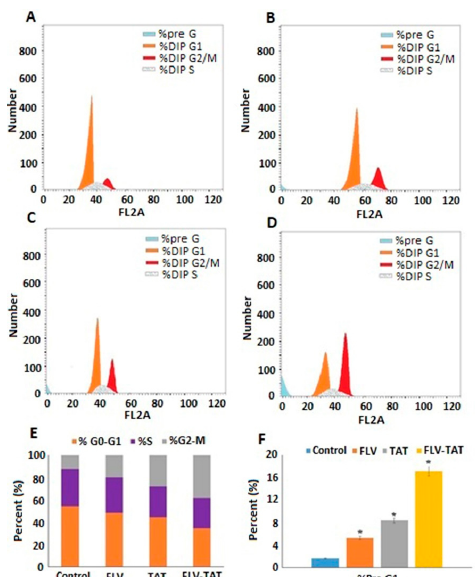
Figure 5. Impact of the treatments on the cell cycle phases. ( A ) Control, ( B ) raw FLV, ( C ) TAT, ( D ) optimized FLV–TAT, and ( E , F ) graphical presentation of each phase. All incubation continued for 48 h. Data represent the mean of six independent replicates ± SD. * Significantly different ( p < 0.05) relative to the corresponding control.